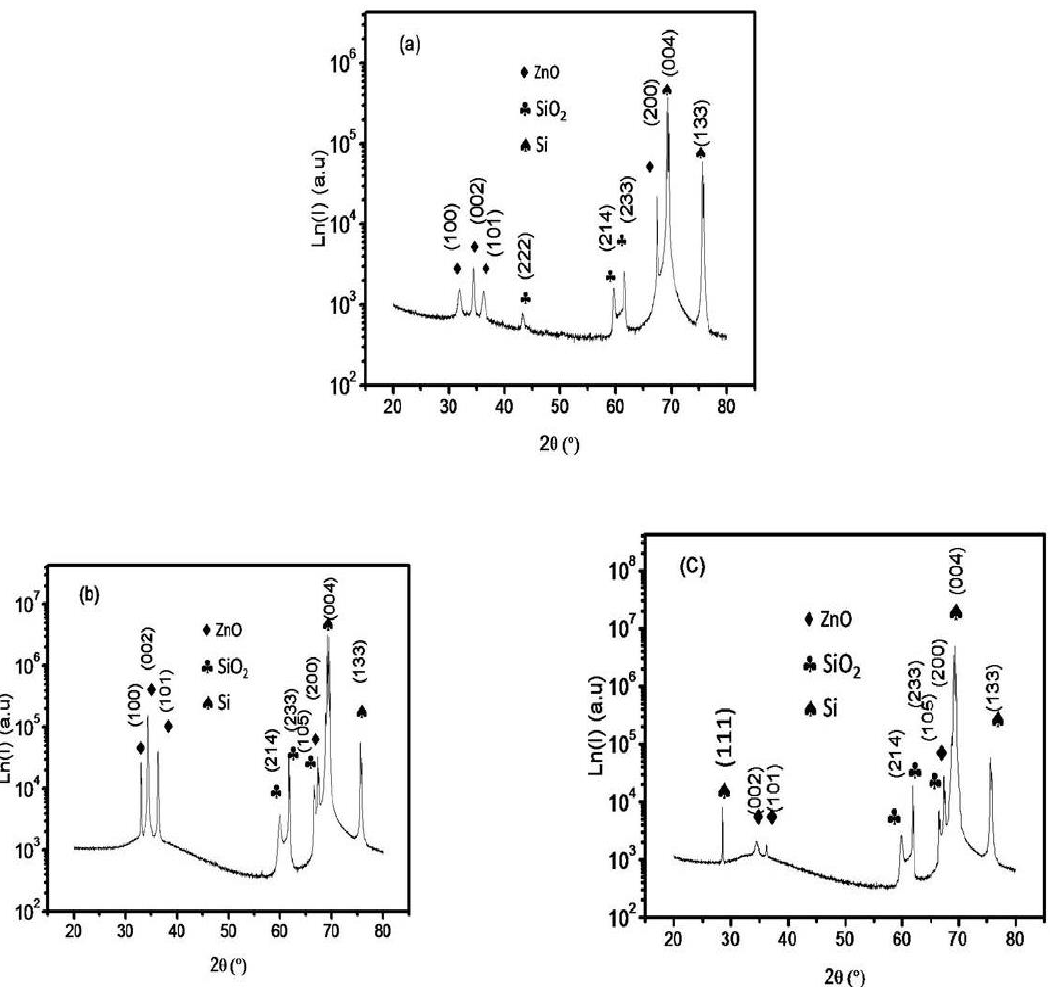
Figure 3. XRD spectra of the ZnO films synthesized by the PECVD method. ( a ): substrate heated at 200 °C, ( b ): substrate heated at 300 °C, ( c ): substrate heated at 400 °C.